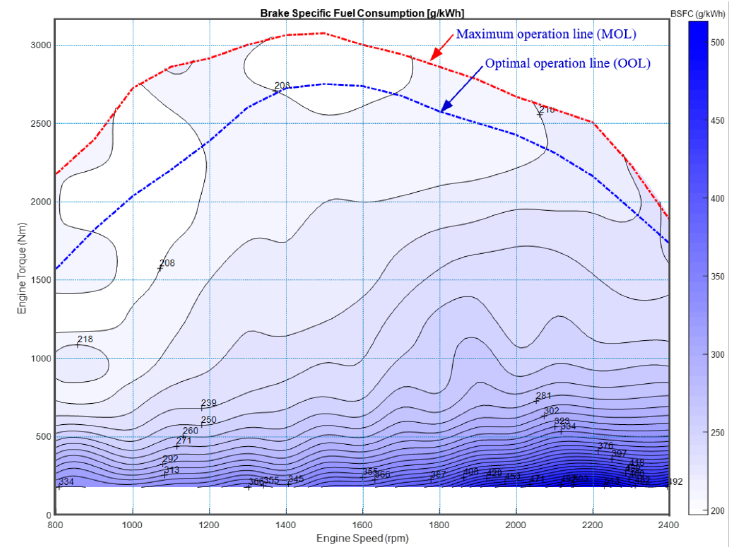
Figure 3. BSFC map of the selected diesel